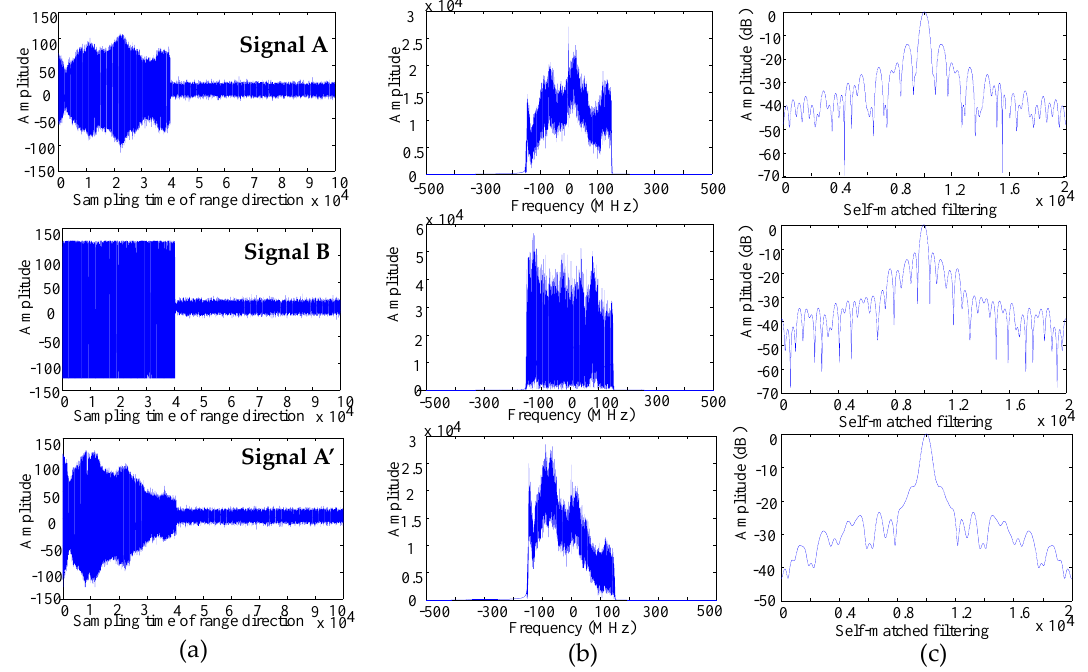
Figure 7. Signal A (without saturation), signal B (with saturation) and signal A’ (without saturation, but with the ramp-modulation effect) on main lobe time. ( a ) IF direct signal in time domain; ( b ) frequency spectrum of the complex baseband signal; ( c ) self-matched filtering